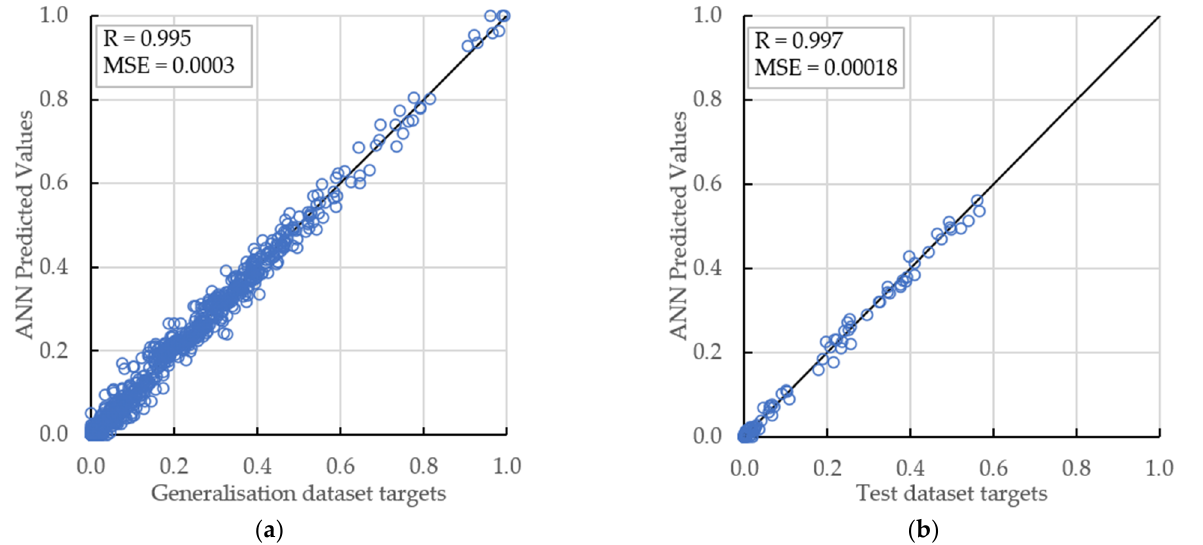
Figure 12. ANN-predicted values against the respective targets of the ( a ) generalisation dataset and ( b ) test dataset.